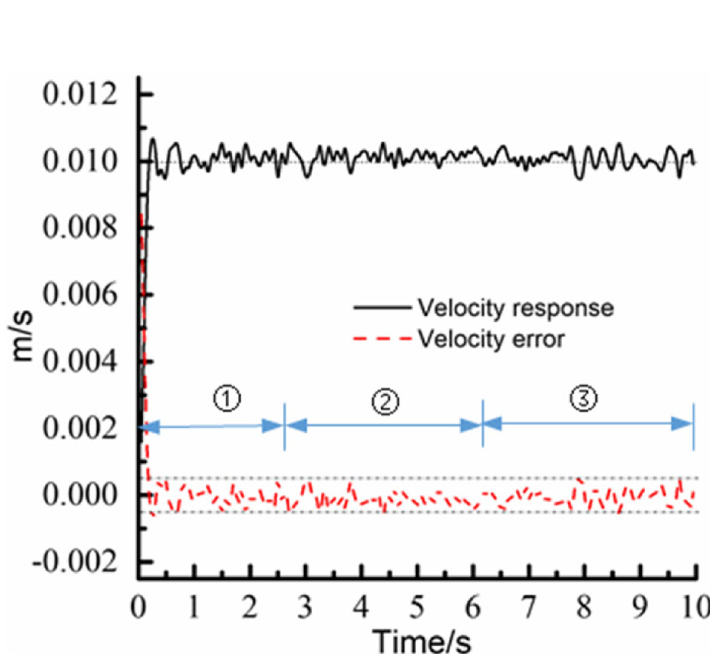
Fig. 10 Speed response under 0.02